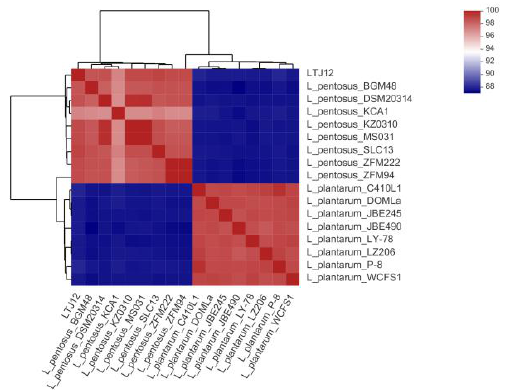
Average amino acid identity (AAI) is an average based on the comparison of all orthologous amino acid sequences between two genomes, and is mainly used to assess the relationship between species at the genome-wide level. The larger the AAI value, the number was 369), while L. pentosus SLC13 had the unique homologous genes with 120 greater the similarity between the two samples. Generally, the AAI value between the (Figure 7A). The pan-genome size of the seven strains is 4746.0, and the core-genome size same species is above 95%. AAI analysis was performed with strain LTJ12 based on the is 2235. As the number of strains increased, the number of pan-genes continued to increase complete genomes of 8 strains of L. plantarum and 8 strains of L. pentosus (Figure 6). The (Figure 7B), while the number of core genes decreased and tended to be stable (Figure 7C). results showed that the AAI values of strain LTJ12 and 8 strains of L. plantarum ranged The results indicated that the L. pentosus population was an open genome. New genome from 88.46% to 88.79%, and the AAI value between strain LTJ12 and L. plantarum WCFS1 sequencing will continue to increase the size of the total gene pool (Figure 7D). At the same was the lowest (88.46%). However, the AAI values of strain LTJ12 and 8 strains of L. pen- time, it also reflects the huge number of pan-genomes of L. pentosus species. L. pentosus is tosus were all greater than 97.32%, which proved that strain LTJ12 had a higher homology widely distributed and exchanges various genetic materials with the outside world. The with L. pentosus , and the AAI value between LTJ12 and L. pentosus SLC13 was the highest species has the diversity of genomic characteristics and the variability of evolutionary at 99.07%. directions.